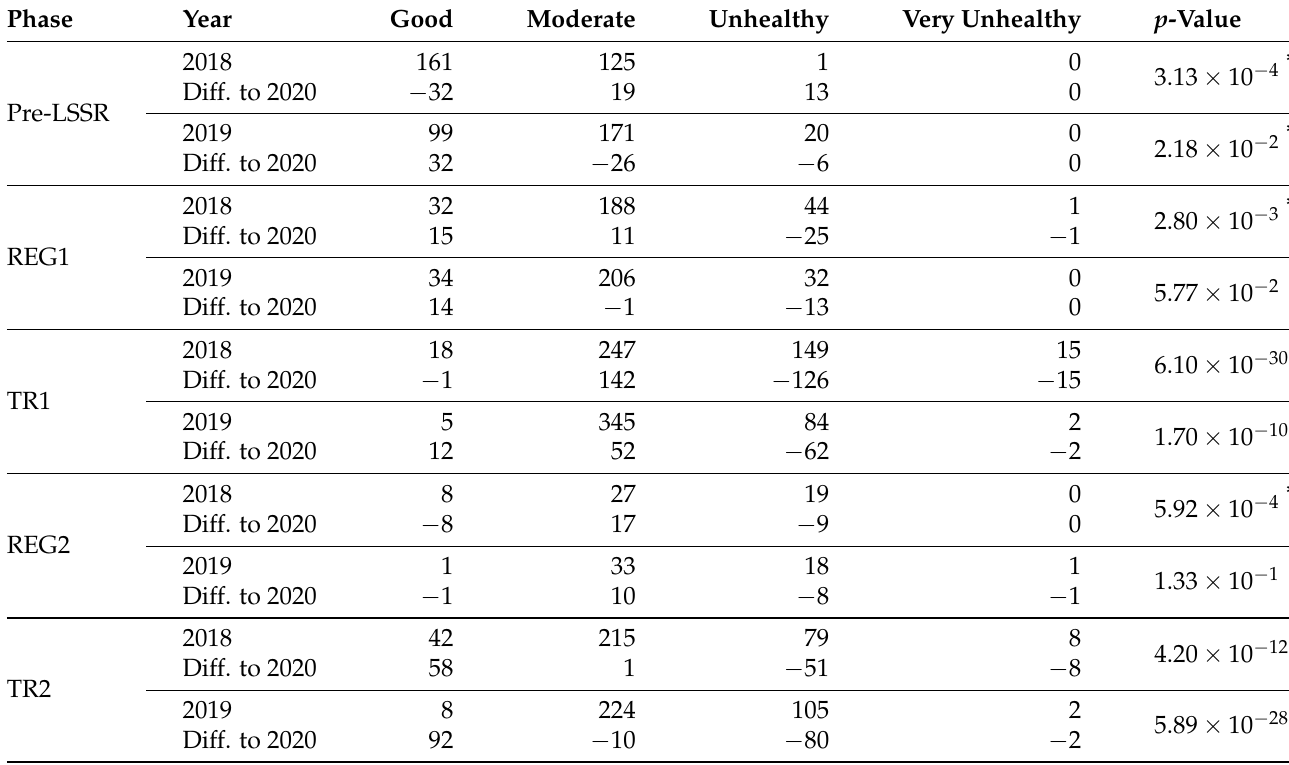
* Significant at 95% confidence level ( α =